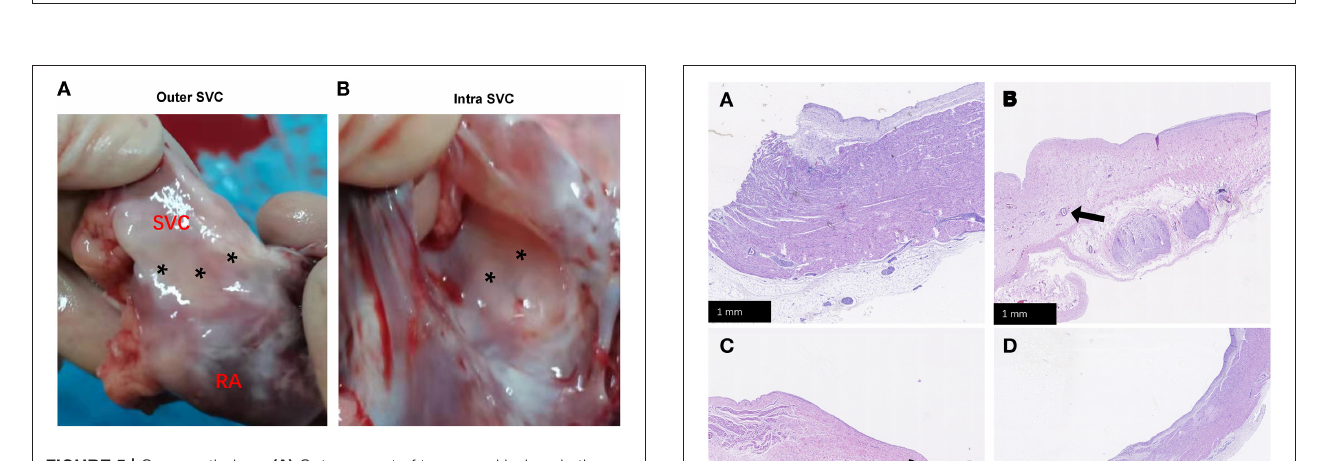
FIGURE 5 | Gross pathology. (A) Outer aspect of transmural lesions in the SVC. (B) Intra aspect of the same lesions in SVC. SVC, superior vena cava. Asterisks indicate the ablation area.